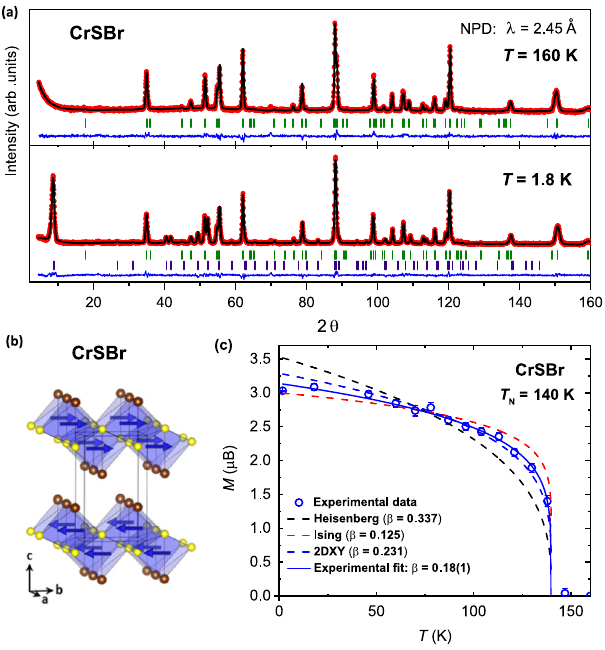
Fig.2|Long-rangemagneticorderinCrSBr.a Rietveldre fi nementoftheneutron powder diffraction (NPD) data at 160K (upper panel) and 1.8K (lower panel) for CrSBr. The red dots correspond to the observed intensities, the black line to the calculated intensity and the blue line is the difference plot. Green and purple ticks show the Bragg re fl ections for the structural and magnetic phase, respectively. b SolvedmagneticstructureofCrSBrfromNPDdata.Sulfurandbromineatomsare shown in yellow and brown color, and Cr atoms are omitted for clarity. The mag- netic moments are ferromagnetically aligned along the b -direction within the monolayer. The ferromagnetic layers are then interlayer coupled anti- ferromagnetically. c Temperature dependence of the re fi ned magnetic moment (blue circles). The error bars represent the standard deviation of the fi tted values. The dashed lines correspond to the power law M / ð T N (cid:2) T Þ β with the different critical exponents of the corresponding models. The continuous blue line is the fi t to the measured